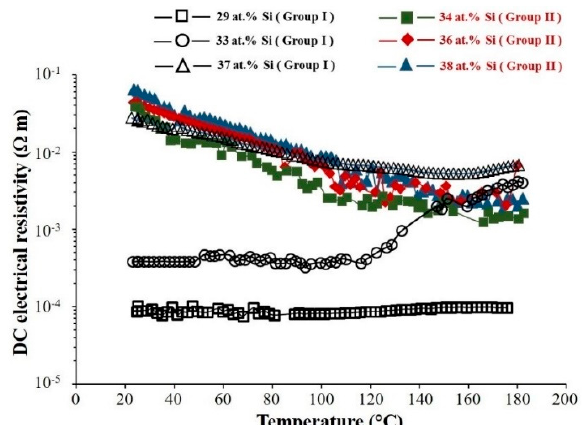
Figure 8. DC electrical resistivity of Mg 2 Si films vs. temperature for different Si atomic concentrations. (Group I: R P < 7 × 10 − 4 Pa and Group II: R P ≥ 7 × 10 − 4 Pa).